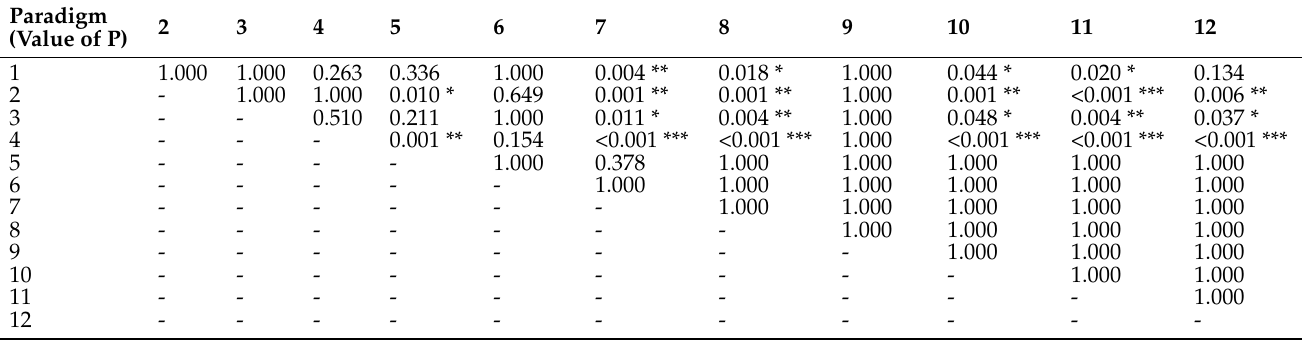
Table A4. Bonferroni Post-Hoc Analysis of Pupil Diameter at Fatigue Level 1 among Twelve